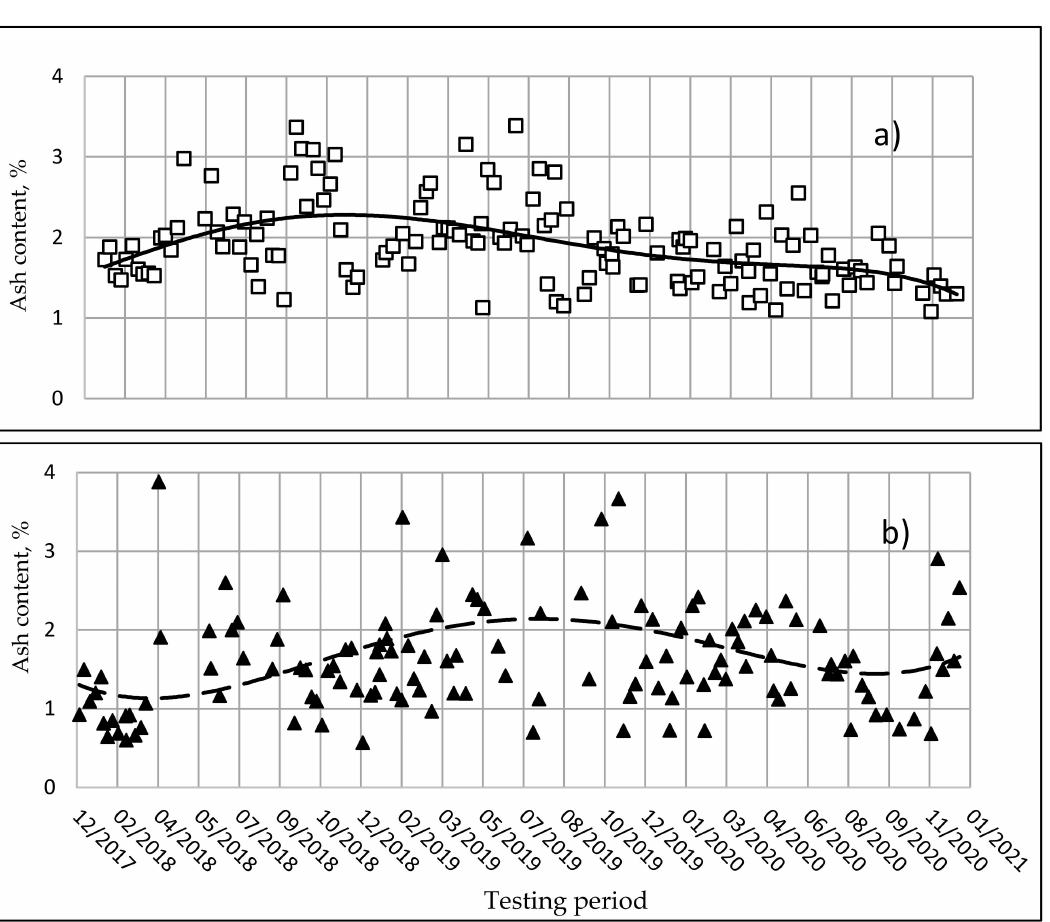
Figure 6. Daily average of ash content values and trendlines curves: ( a ) company M; ( b ) company